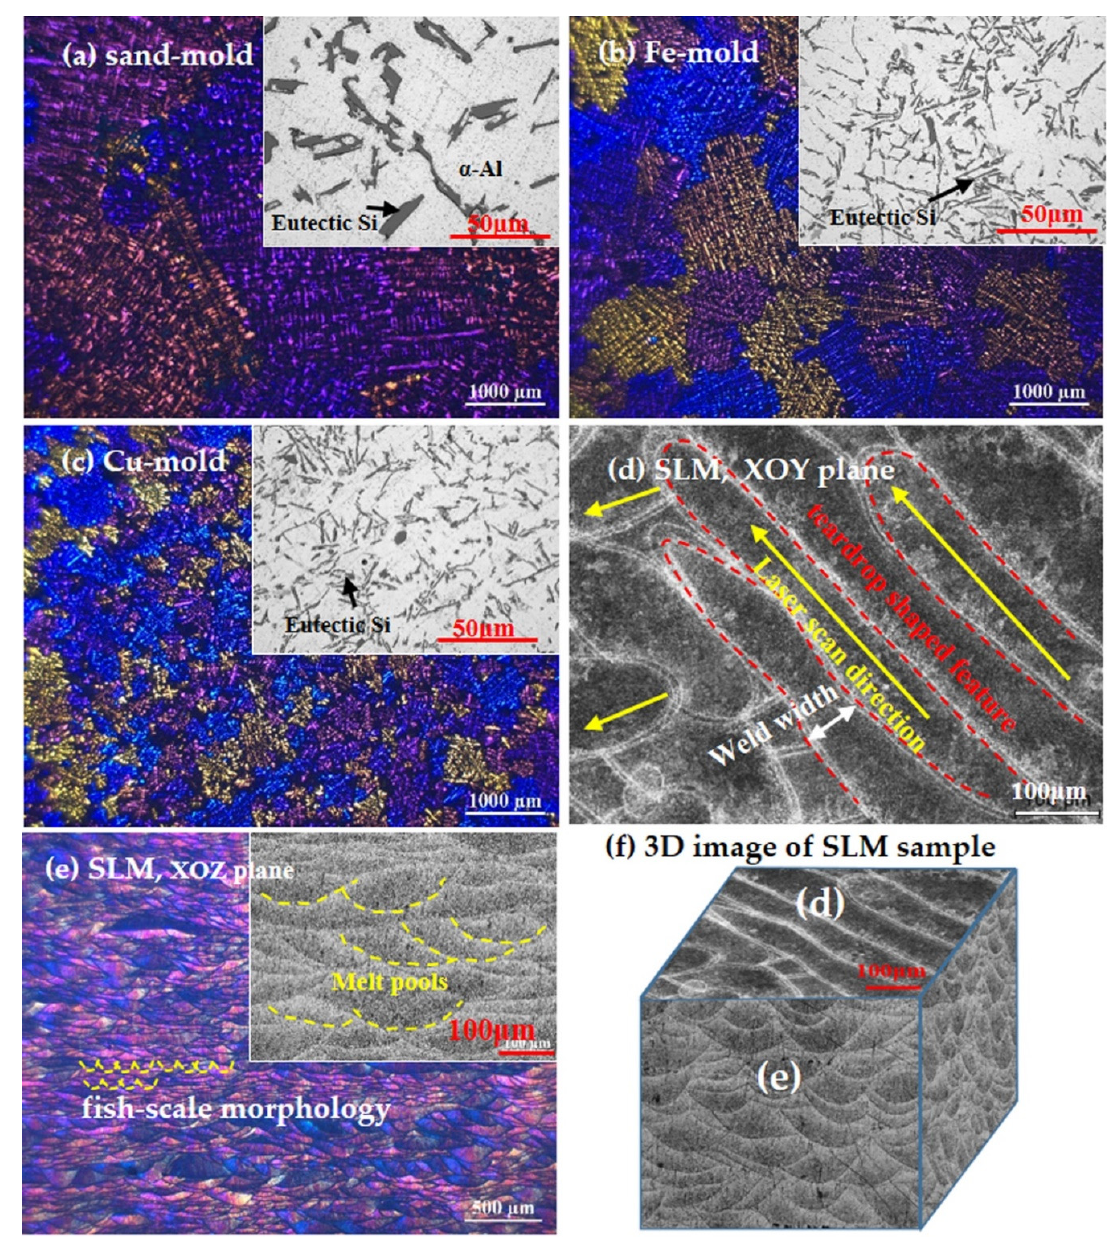
Figure 5. Optical microstructure of Al-10Si-0.5Mg alloys prepared with: ( a ) sand-mold, ( b ) Fe-mold, ( c ) Cu-mold and ( d , e ) SLM. The image at upper-right corner of ( a – c ) is the enlarged view; ( f ) 3D microstructure of SLM alloy constructed with OM images. The color images were observed under the polarized light mode of a microscope to display the grain morphology. Note that the magnification of ( d ) is different from that of ( a – c ) to display tiny melt pools